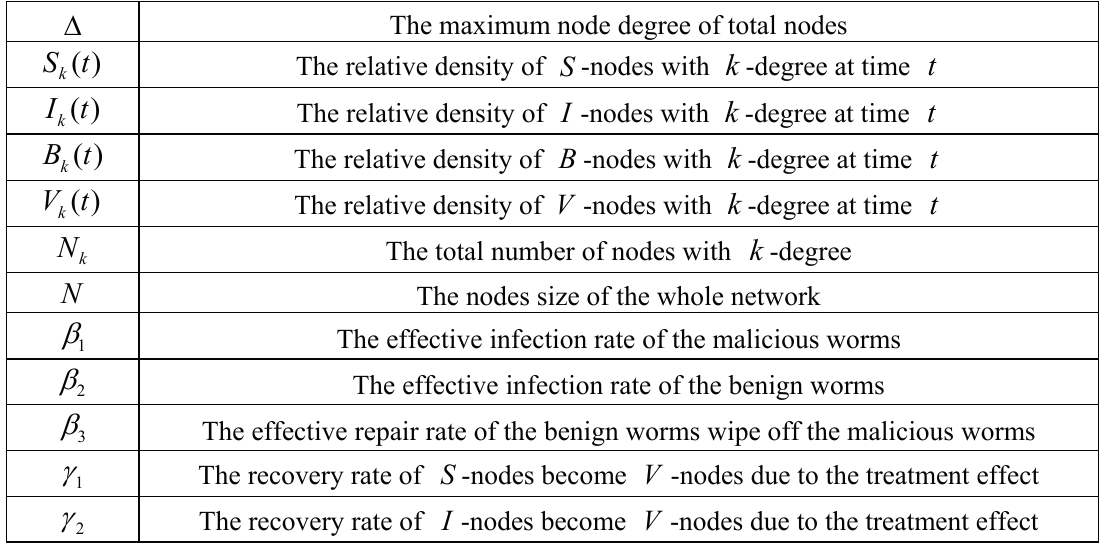
Table 1. Notations of this